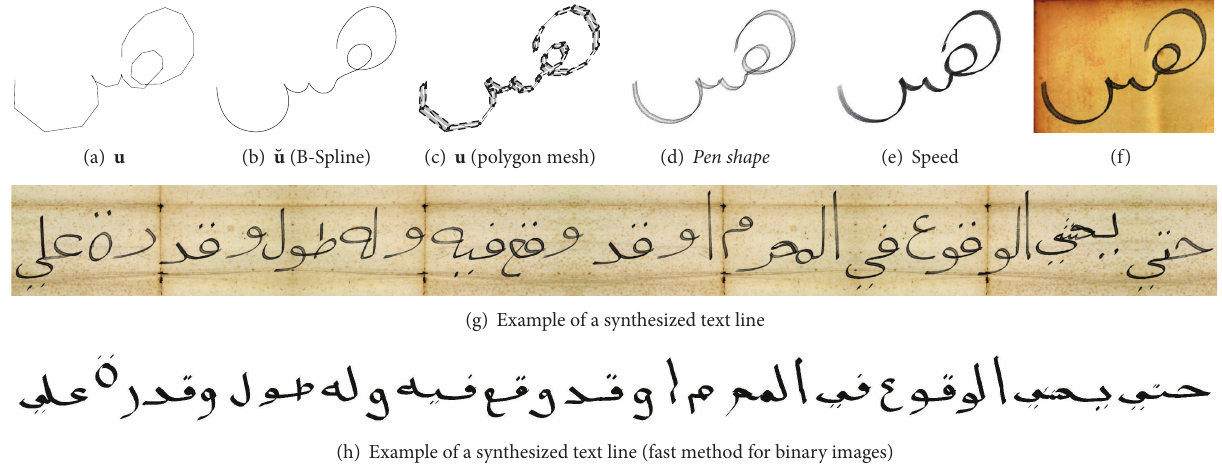
Figure 11: From the polygon u to a synthetic image that simulates a feather like writing instrument. (c) Polygon mesh created from u that is used for fast rendering of binary